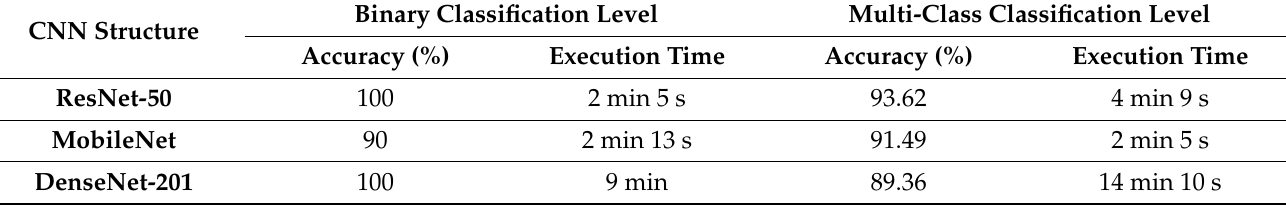
Table 6. The classification testing accuracy (%) and execution training time for the three CNNs for both binary and multi-class classification.